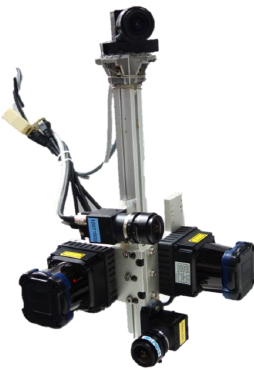
Figure 5. Hand-held sensor system for experimental validations. It consists of two 2D lidars headed to the ceiling and three cameras headed to the side of the lidars and heading to the direction of the system. We use only two 2D lidars for pose estimation. The cameras are attached to obtain color information. The maximum scan rate of the system is about 20 Hz. The system is fully calibrated, including both intrinsic and extrinsic parameters.